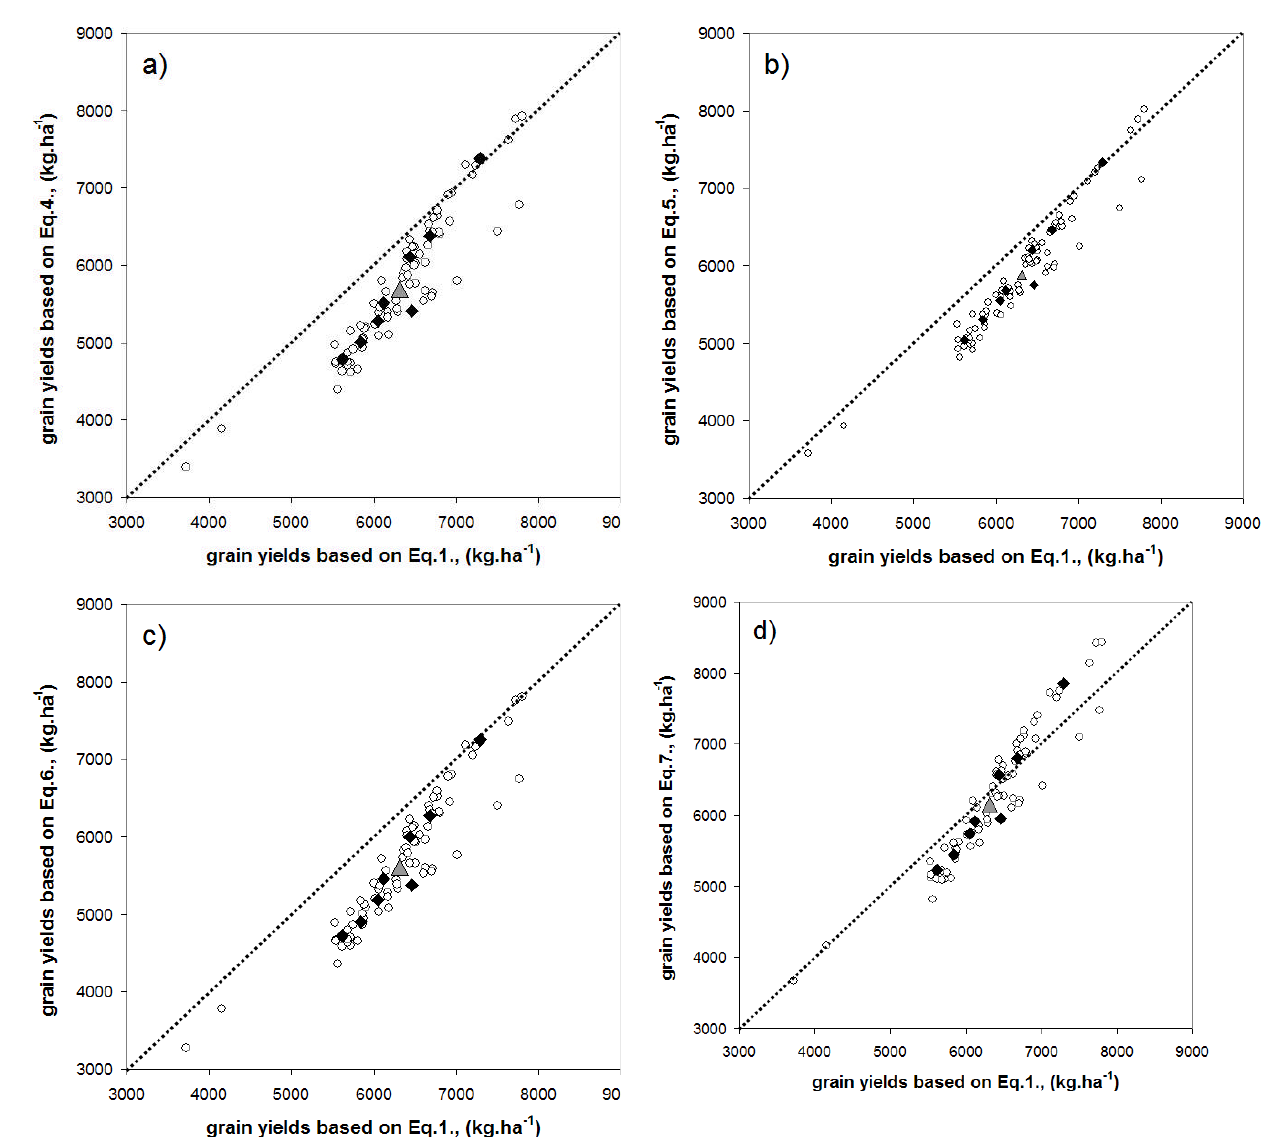
Figure 5. Comparison of the mean winter wheat yields in the Czech Republic aggregated to different administrative regions during 1961-2000 period. The mean grain yield estimates on level of NUTS 4 (n = 77) marked as white circles; NUTS 2 (n = 8) marked as black rhombs and NUTS 0 mark as gray triangle were considered. The yield estimates on the x-axis are always based on the Eq. (1) whilst the y-axis yields were attained through model runs with R estimates based on: a) Eq. (4); b) Eq. (5); c) G Eq. (6) and d) Eq.